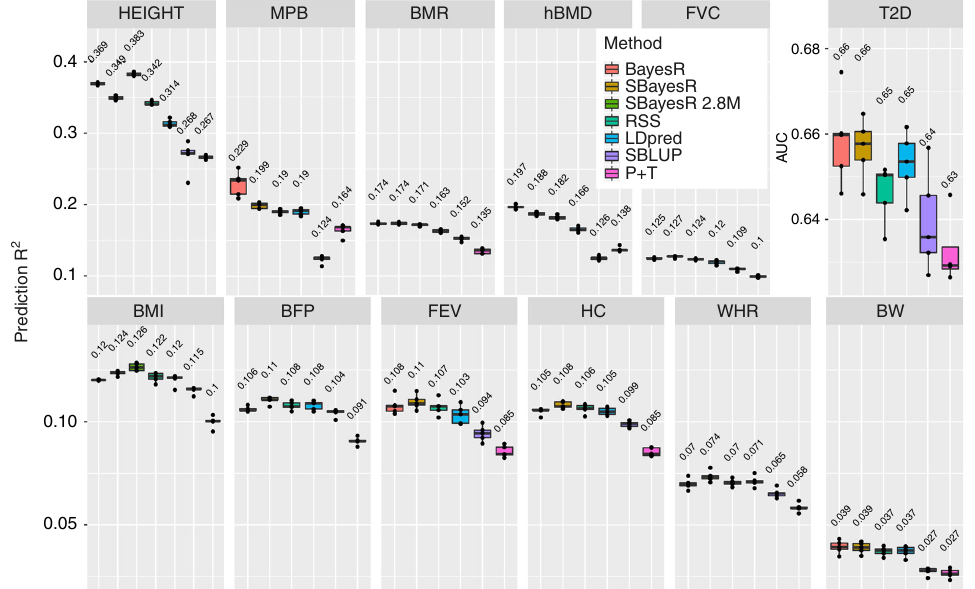
Fig. 2 Prediction accuracy in fi vefold cross-validation for 12 traits in the UK Biobank. Panel headings describe the abbreviation for 12 traits including standing height (HEIGHT, n = 347,106), male-pattern baldness (MPB, n = 125,157), basal metabolic rate (BMR, n = 341,819), heel bone mineral density T - score (hBMD, n = 197,789), forced vital capacity (FVC, n = 317,502), type 2 diabetes (T2D, n = 274,271), body mass index (BMI, n = 346,738), body fat percentage (BFP, n = 341,633), forced expiratory volume in 1 s (FEV, n = 317,502), hip circumference (HC, n = 347,231), waist-to-hip ratio (WHR, n = 347,198) and birth weight (BW, n = 197,778). Each panel shows a boxplot summary of the prediction accuracy across the fi ve folds with the mean across the fi ve folds displayed above each method ’ s boxplot. The centre line inside the box is the median, the bottom and top of the box are the fi rst and third quartiles, respectively (Q1 and Q3), and the lower and upper whiskers are Q1 – 1.5 IQR and Q3 + 1.5 IQR, respectively, where IQR = Q3 – Q1. The points depict the prediction accuracy for each replicate. Traits are ordered by mean estimated h 2 (see Supplementary Fig. 16) from highest to SNP